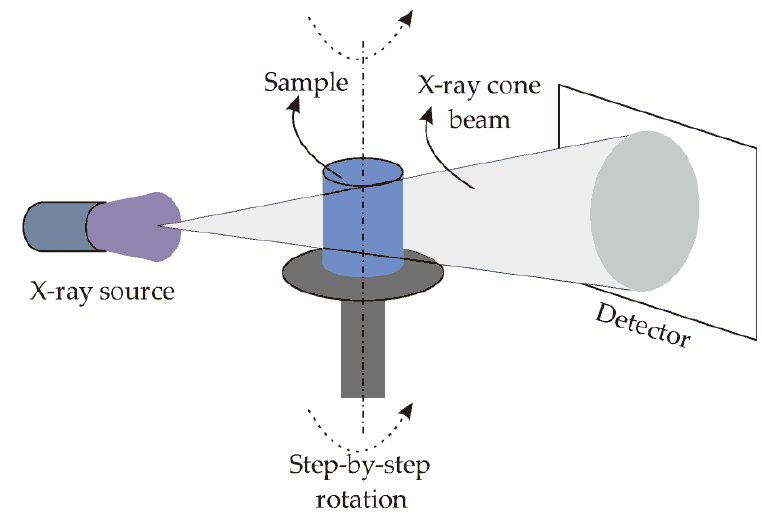
Figure 1. Simplified schematic of the X-ray CT system [26].